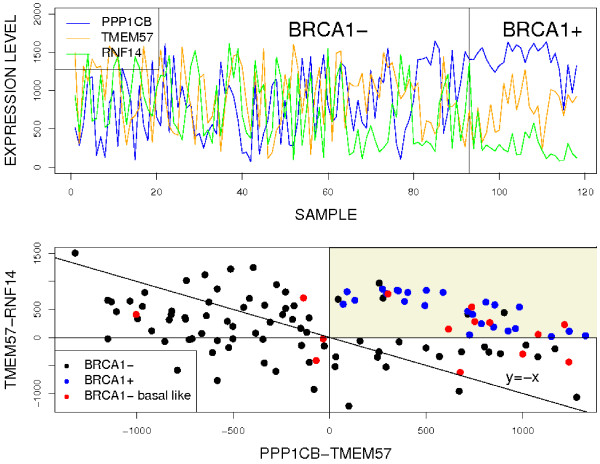
Expression patterns for the top-scoring BRCA1 triplet. Top: Expression pattern of the top-scoring triplet (PPP1CB, TMEM57, RNF14). The horizontal axis represents samples, with a vertical line separating the BRCA1 negative from the BRCA1 positive samples. The vertical axis is the rank of each genes' expression level within each sample. Bottom: Scatter plot of rank differences. The horizontal axis is the difference between the ranks of PPP1CB and TMEM57 within each sample, while the vertical axis is the difference between the ranks of TMEM57 and RNF14 for each sample. The shaded area corresponds to the ordering that is unique to the BRCA1 mutant cases.